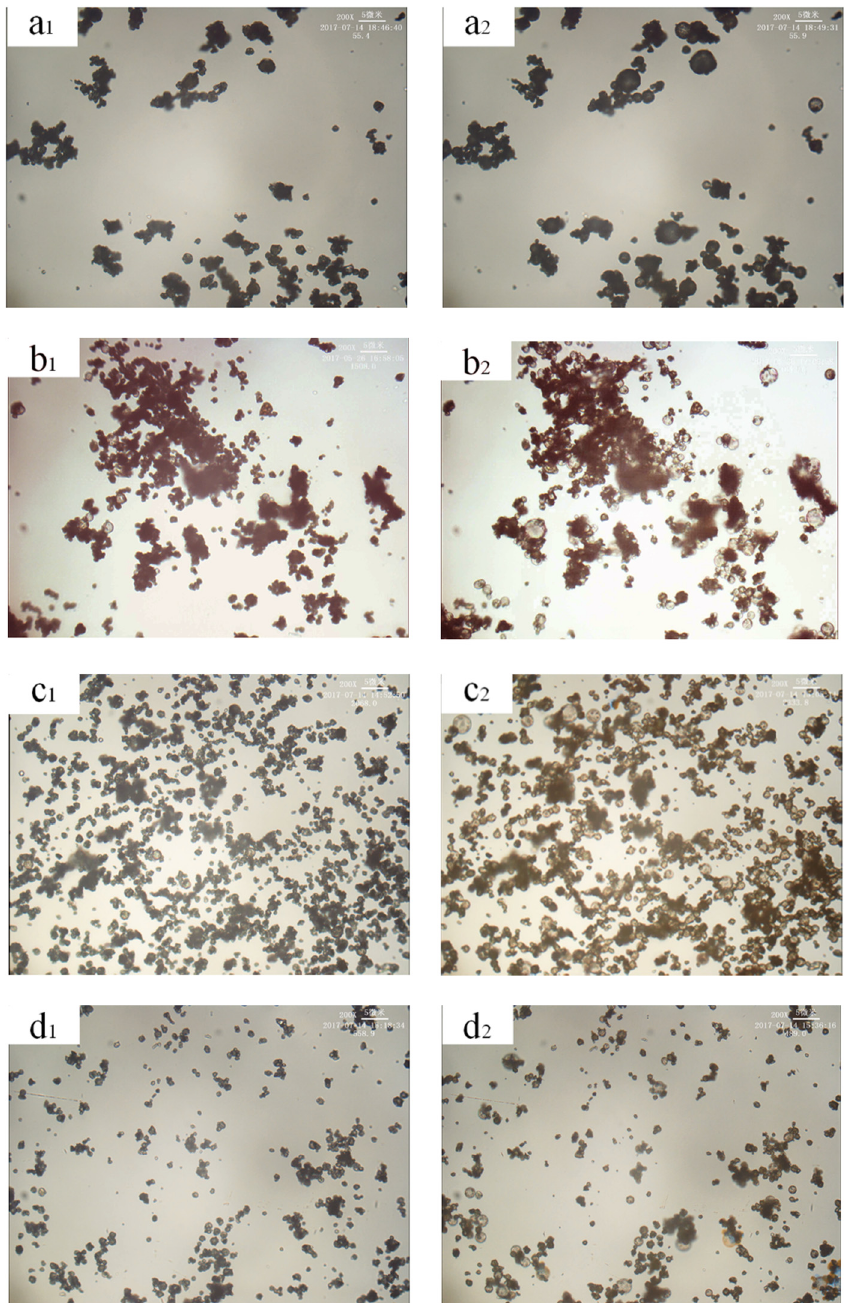
Figure 3: E ff ect of di ff erent content of foaming agent on the expansion properties of microspheres under the conditions of a certain expansion temperature and crosslinking agent content ( see Table 1 ) . ( a – d ) The foaming agent content: 11.7 wt%, 28.5 wt%, 39.9 wt%, 48.1 wt%. ( a 1 – d 1 ) Pre - expansion sample and ( a 2 – d 2 ) expanded